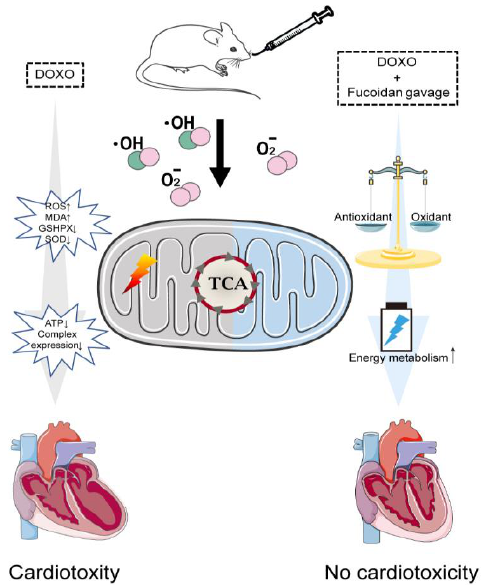
Figure 6. Schematic illustration of fucoidan preventing DOXO-induced cardiotoxicity. DOXO triggers cardiotoxicity via elevating oxidative stress and increasing mitochondrial function injury ( left ). Fucoidan protects against DOXO-induced cardiotoxicity by reducing oxidative stress and enhancing mitochondrial energy metabolism ( right